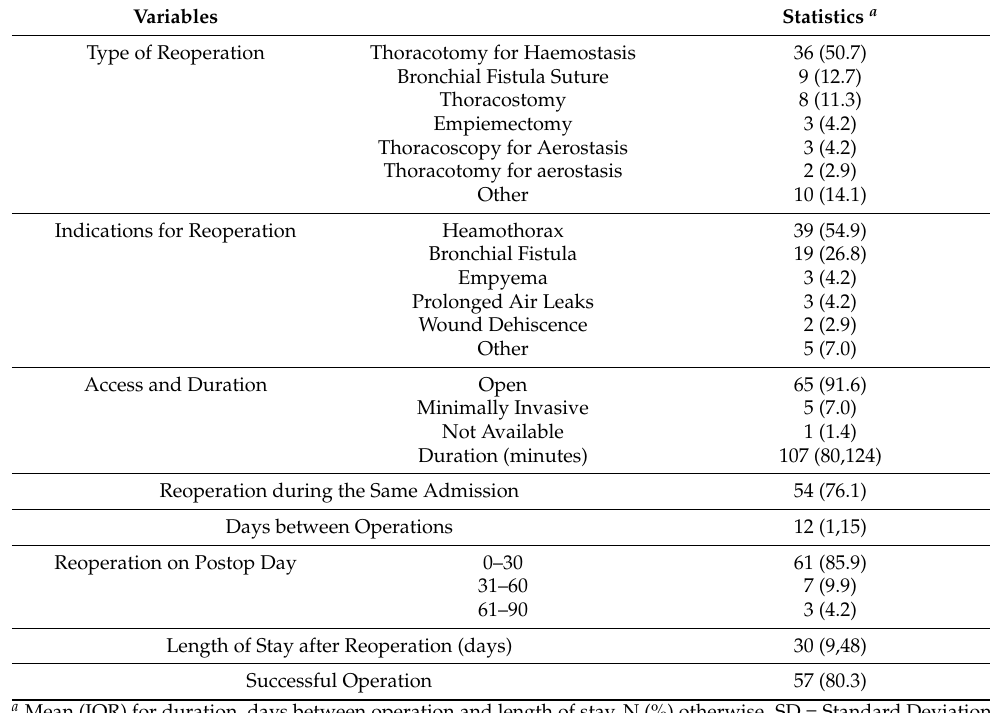
Table 2. Reoperations summary statistics, N =